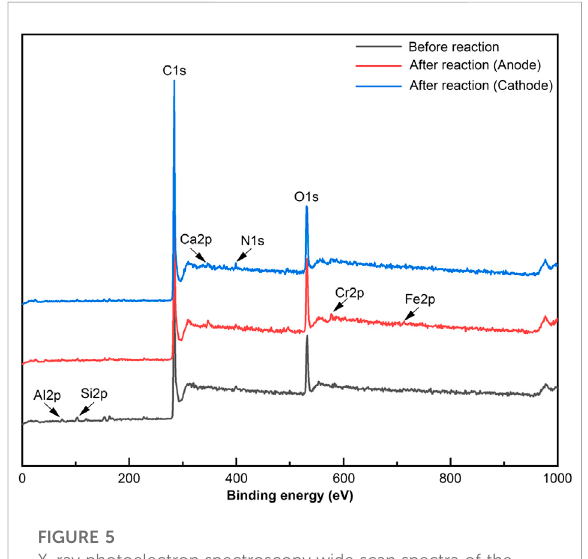
Fourier transform infrared spectroscopy spectra of the